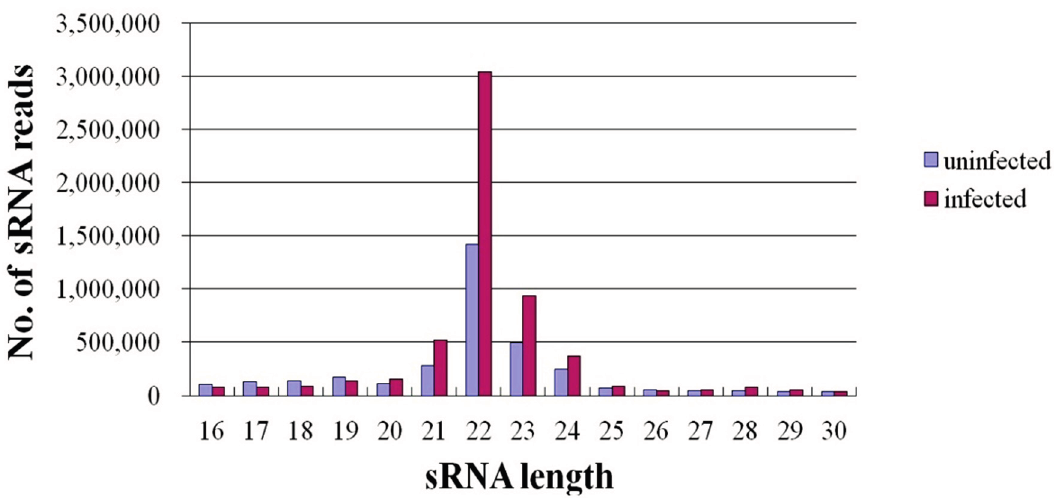
Figure 1. Length distributions of small RNAs in Japanese encephalitis virus (JEV)-infected and -uninfected PK-15